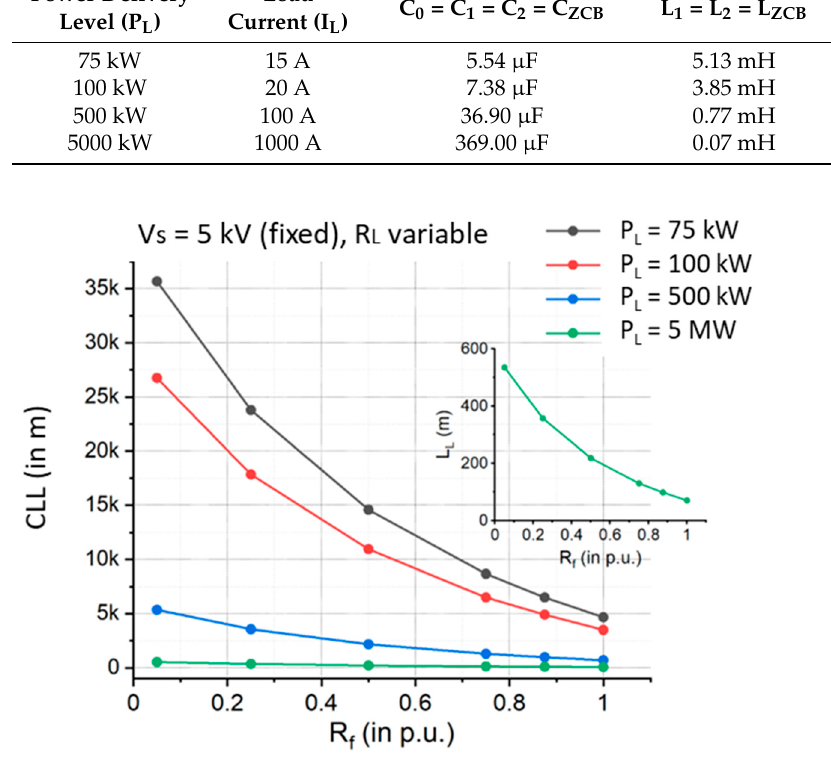
Figure 4. CLL curves for various load-power requirements. Table 4. Specification of ZCB parameters and fault bases according to power delivery levels.